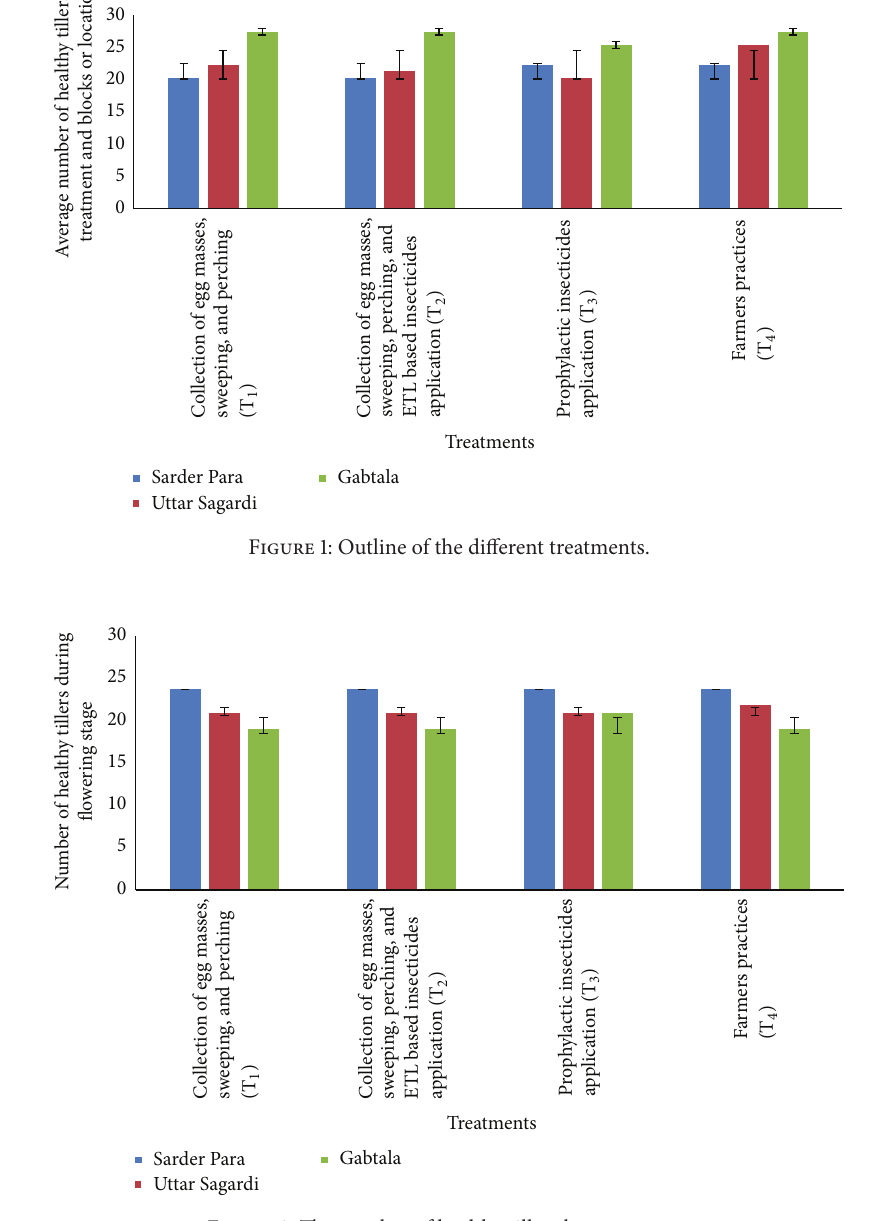
Figure 2: The number of healthy tillers by